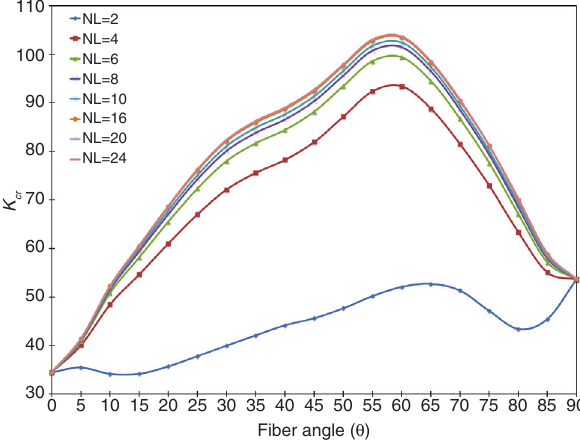
Figure 5 Critical buckling load parameter for simply supported antisymmetric cylindrical skew panel (Ø = 15 ° , α = 30 ° ).